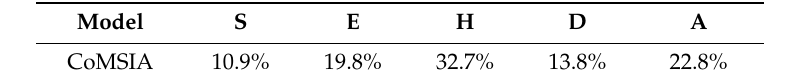
Table 3. Molecular fields’ contribution to the characterization values of double-activity quinolones’ green algae and bacterial genotoxicity estimated by the CoMSIA model.